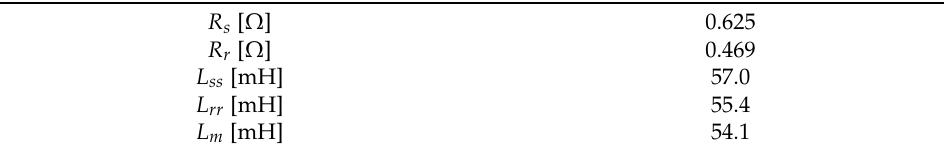
Figure 5. Power electronics model in Simscape. Table 2. Motor model parameters.